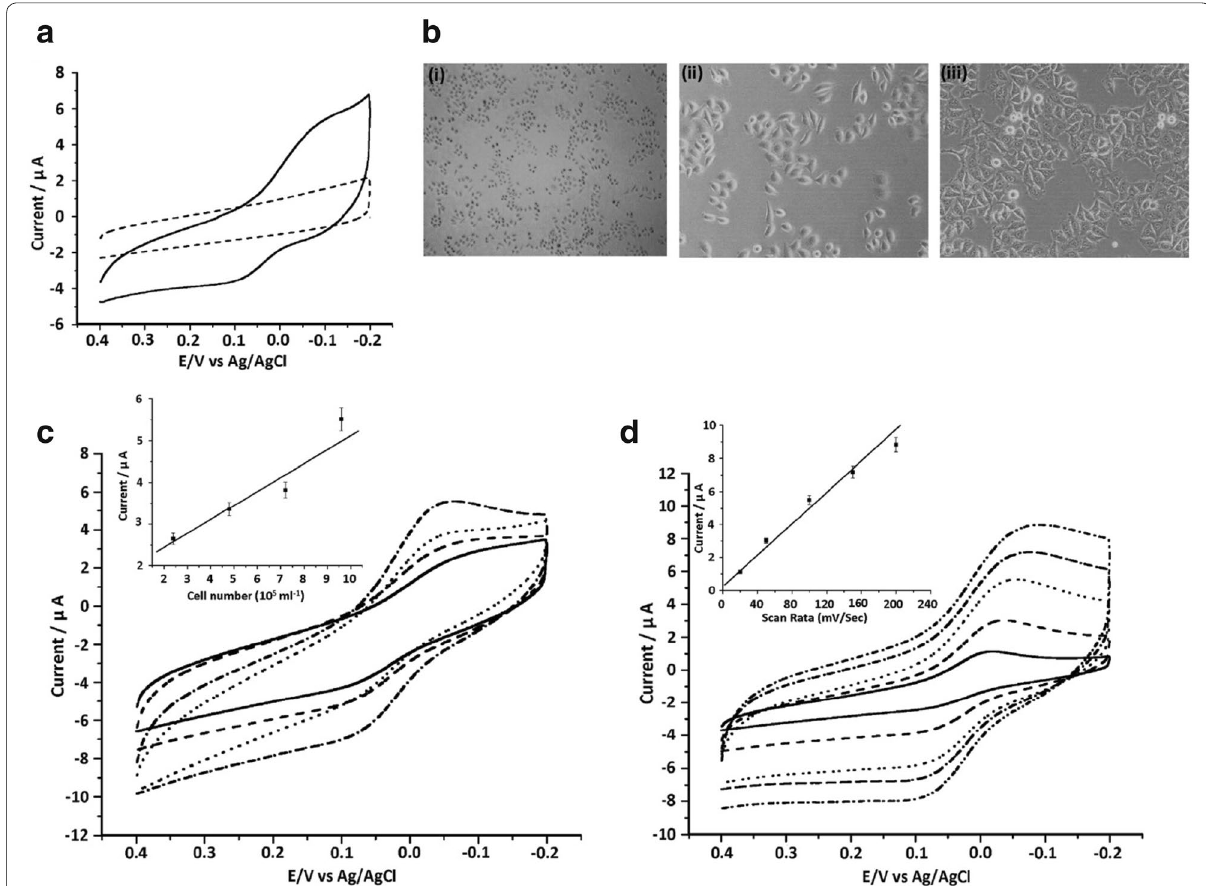
Fig. 3 a CV for HeLa cell on (dashed lines) ITO and (plain curves) thin film of PANI/ITO, cell number was 5.8 on (i) ITO incubated for 48 h, (ii) thin film of PANI/ITO incubated for 24 h and (iii) thin film of PANI/ITO incubated for 48 h. c CV for HeLa cells on PANI/ ITO at different cell numbers, (plain curves) 2.4 of reduction current peak as a function of cell number. The scan rate was 0.1 V s − 1 and the temperature was 37 ITO at different scan rate (plain curves) 20, (dashed lines) 50, (dotted lines) 100, (dash dot dash lines) 150 and (dash dot dot dash lines) 200 mV/s. Inset linear plot of reduction current peak as a function of scan rat. Data is shown as the mean (Reprinted with permission from [36]. Copyright @ 2009